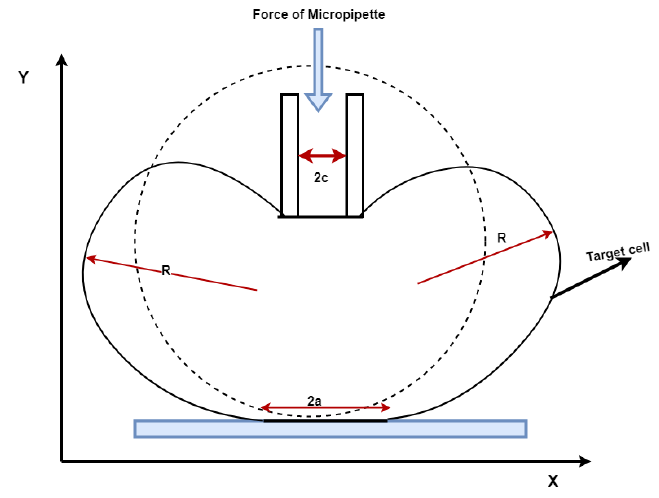
Figure 5. Point load model of injection